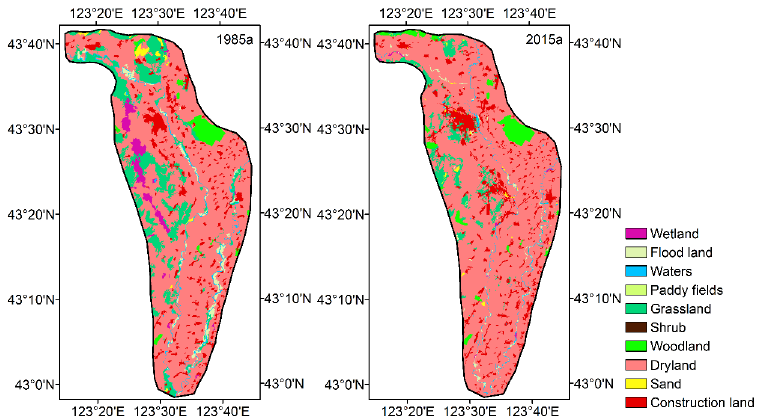
Figure 5. Temporal and spatial evolution of the land use in West Liao River